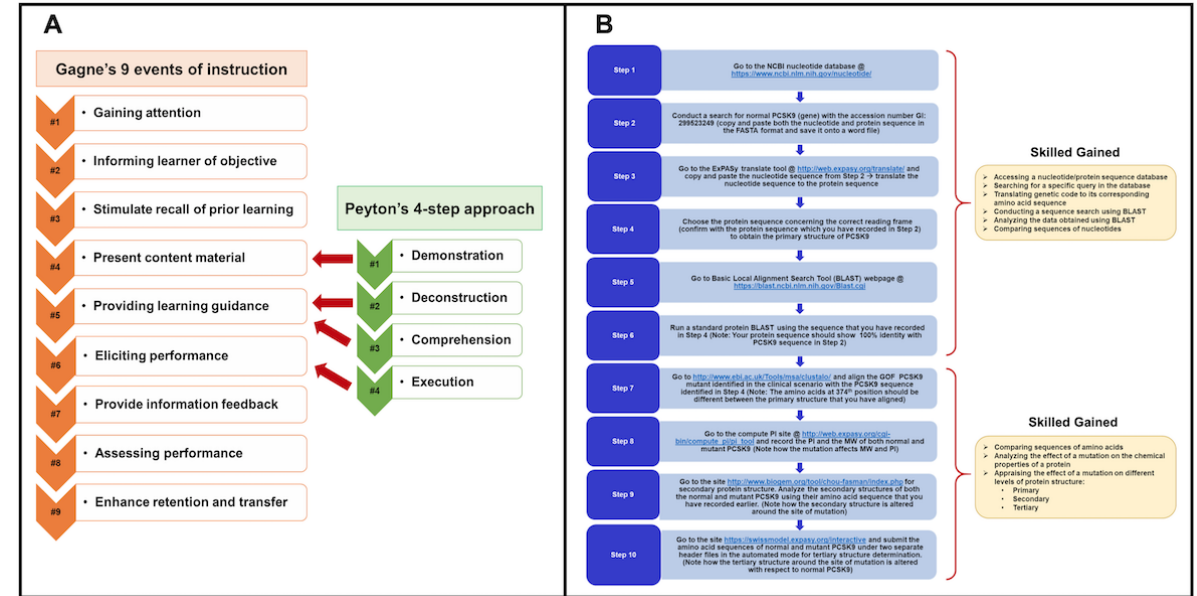
Figure 6. The framework for knowledge translation to be implemented in this study, elaborated using a vignette of autosomal dominant familial hypercholesterolemia. A. Description of the blended lesson plan: Gagne's events of instruction and Peyton's approach. B. The sequential steps of the lesson plan and skills gained. ExPASy: Expert Protein-Analysis System of the Swiss Institute of Bioinformatics; GOF: gain of function; NCBI: National Center for Biotechnology Information; PCSK9: proprotein convertase subtilisin/kexin type 9; PI: isoelectric point; MW: molecular